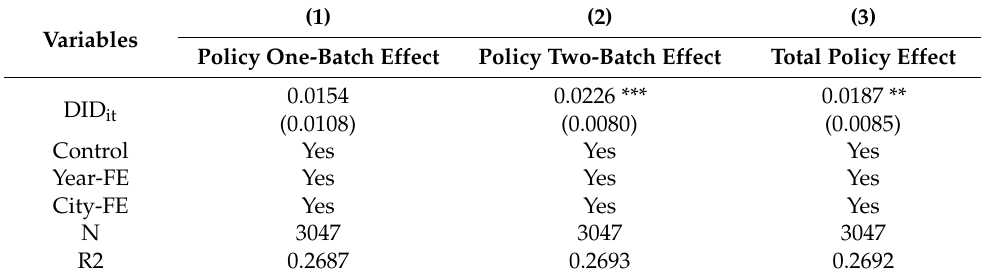
Table 7. Policy Promotion